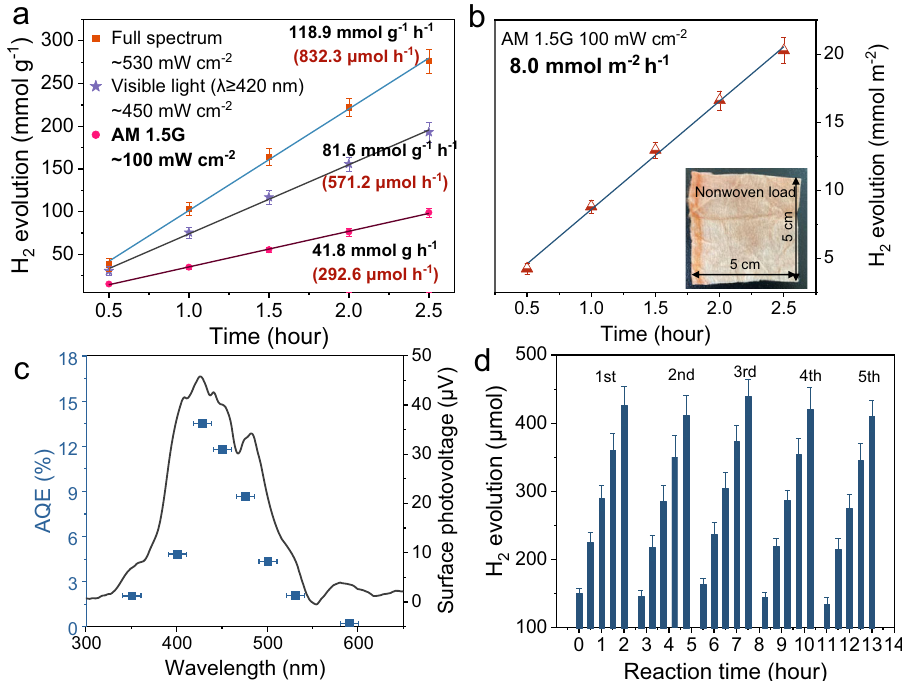
Fig. 2 Photocatalytic hydrogen evolution. a Photocatalytic HER under full spectrum ( λ ≥ 300 nm, light intensity: ∼ 530 mW cm − 2 ), visible light ( λ ≥ 420 nm, light intensity: ∼ 450 mW cm − 2 ) and AM 1.5 G, (100 mWcm − 2 ) of PTA nanosheets. b AM 1.5 G (100 mWcm − 2 ) HER performance of PTA (2 mg) loaded on nonwoven fabrics, inset: optical image of PTA loaded on nonwoven devices. (All error bars are determined from three independent experiments). c The wavelength-dependent AQE for photocatalytic HER over PTA and the surface photovoltage of PTA. (The error bar came from a bandpass fi lter). d The cycle photocatalytic HER performance of PTA under the full spectrum. Reaction conditions: 7.0 mg photocatalyst, 4.6 wt. % Pt as a cocatalyst, 100 mL of a 0.2 M ascorbic acid solution, pH 2.45. (All error bars were determined from three independent experiments). NATURE COMMUNICATIONS| (2022) 13:2067